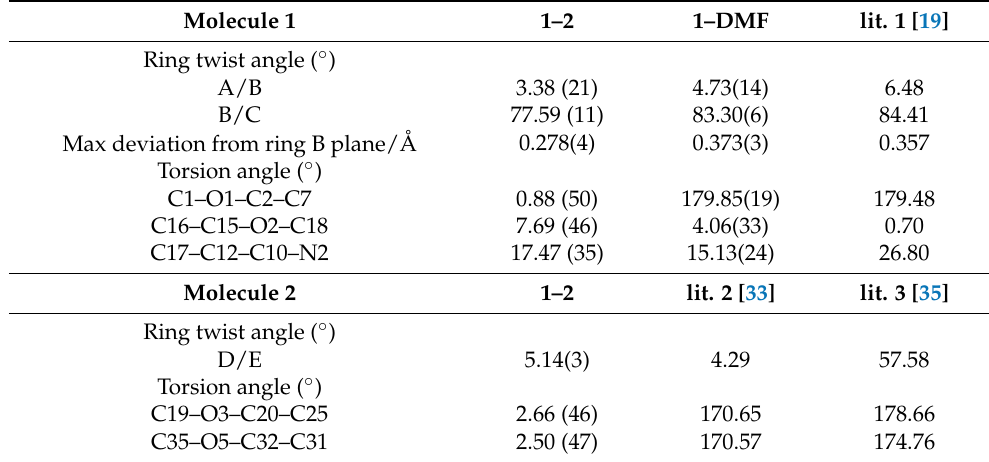
Table 2. Selected geometrical